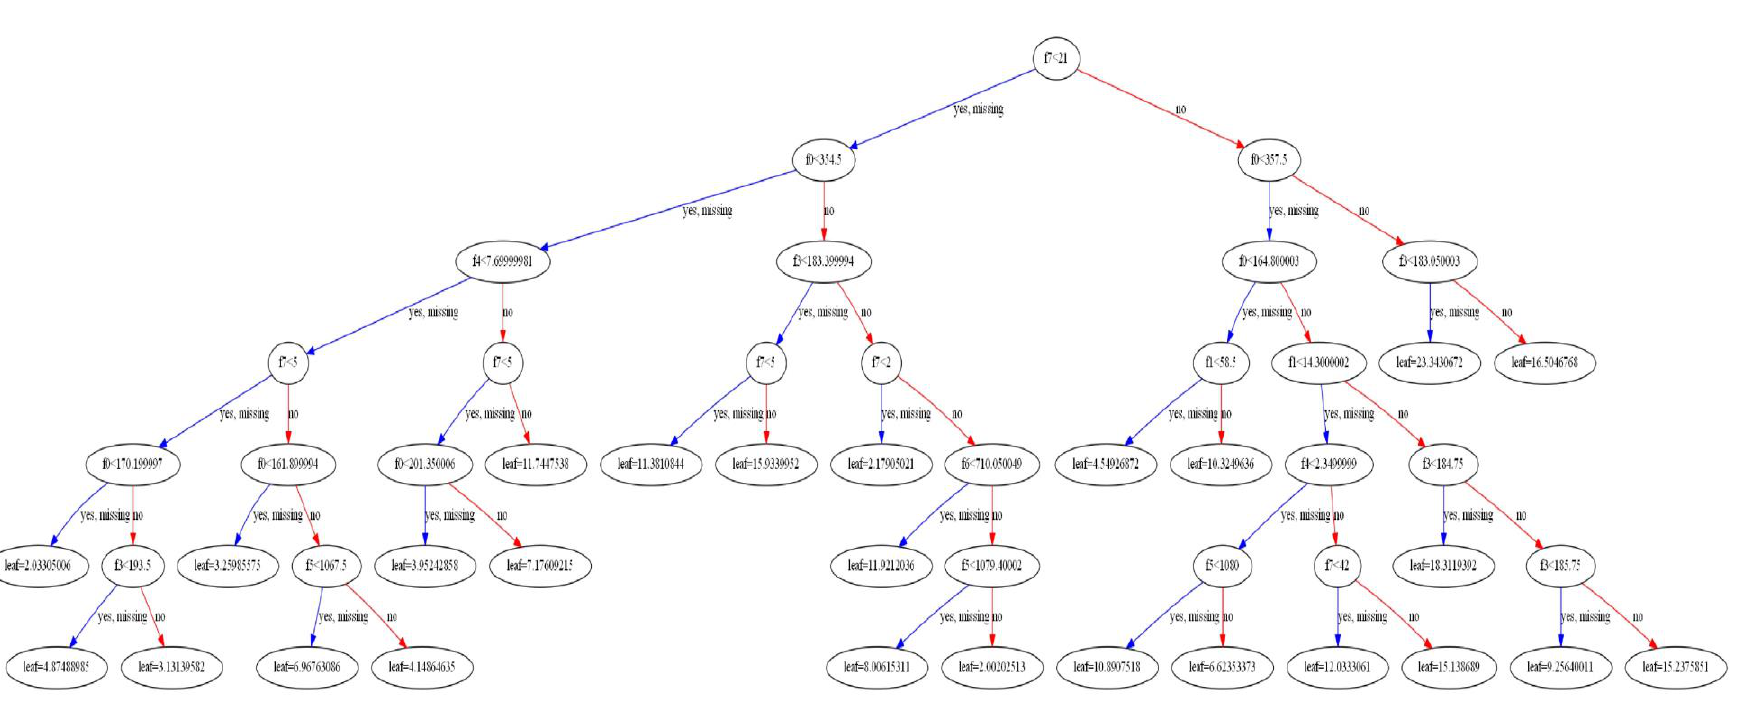
Figure 10. The 1st base estimator.